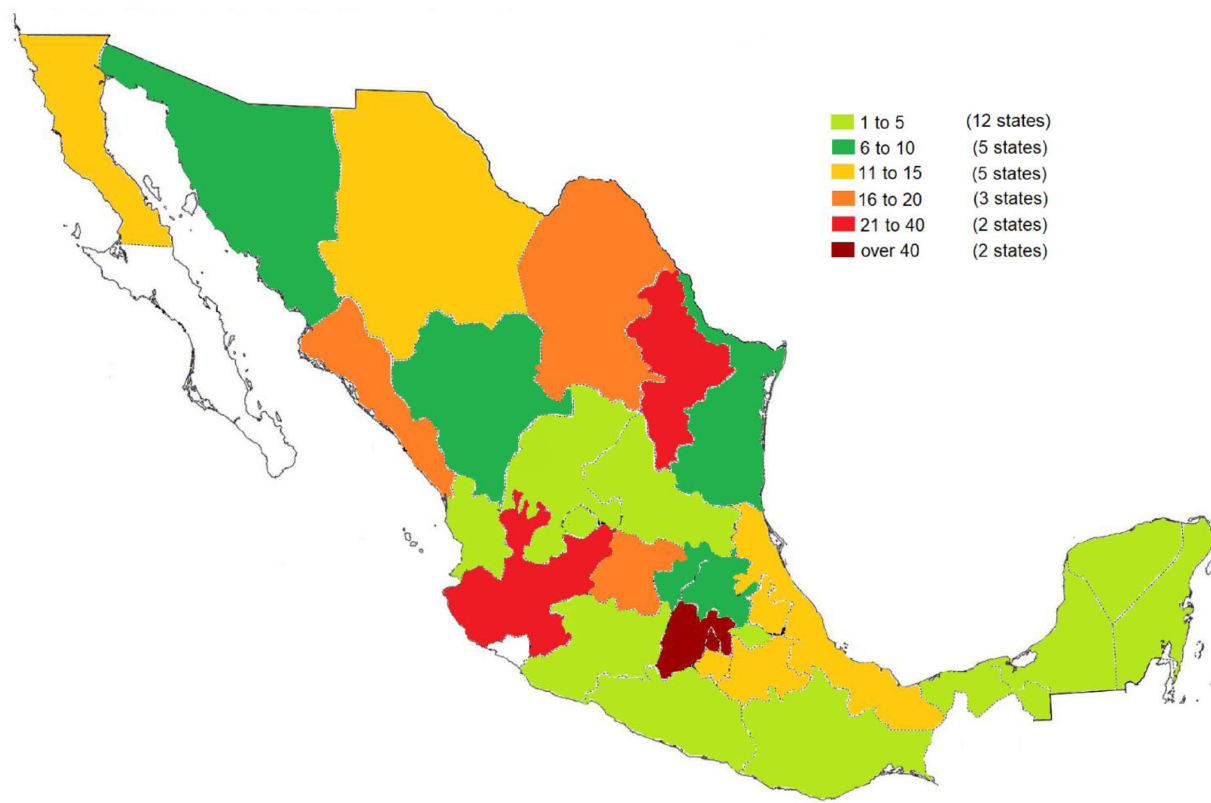
Figure 1. States of the Mexican Republic from which participants took part. The colours represent the number of participants recruited in each state. Mexico City and the State of Mexico (dark red) presented the greatest number of participants (over 40) with IBD. Monterrey and Guadalajara (red) presented 21 to 40 participants with IBD. The states of Coahuila, León and Sinaloa (orange) presented 21 to 40 participants with IBD. Puebla, Morelos, Veracruz, Baja Calicfornia and Chihuahua (yellow) presented 11 to 15 participants with IBD. Pachuca, Querétaro, Ciudad Victoria, Hermosillo and Durango (dark green) presented 6 to 10 participants with IBD. Chilpancingo, Nayarit, Oaxaca, Quintana Roo, San Luis Potosí, Tlaxacala, Yucatán, Aguascalientes, Campeche, Michoacán, Zacatecas and Tabasco (light green) presented 1 to 5 participants with IBD.